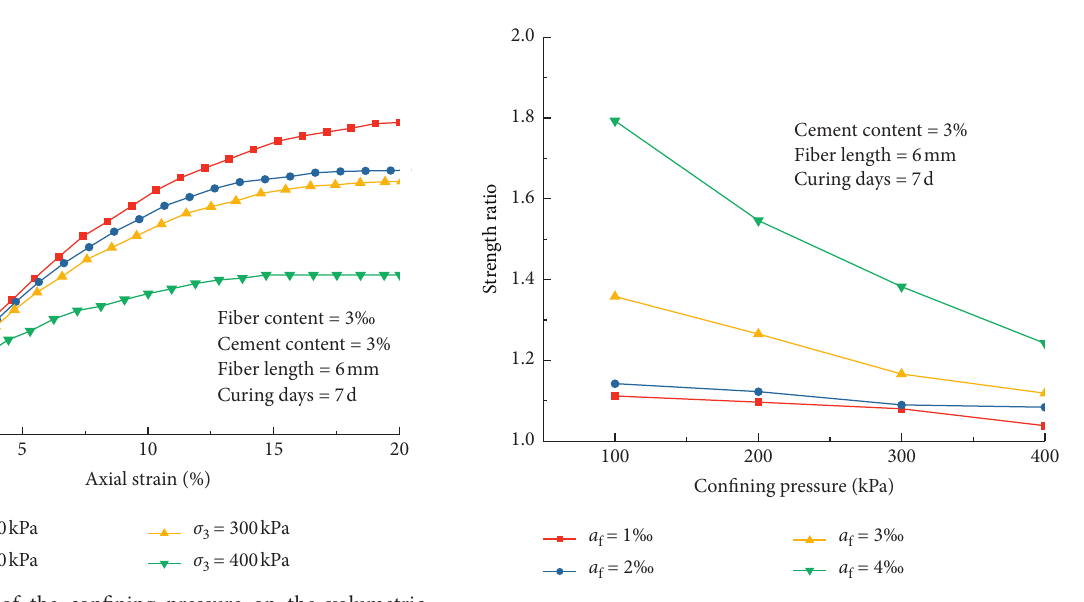
Figure 13: Strength ratio under different confining pressures.